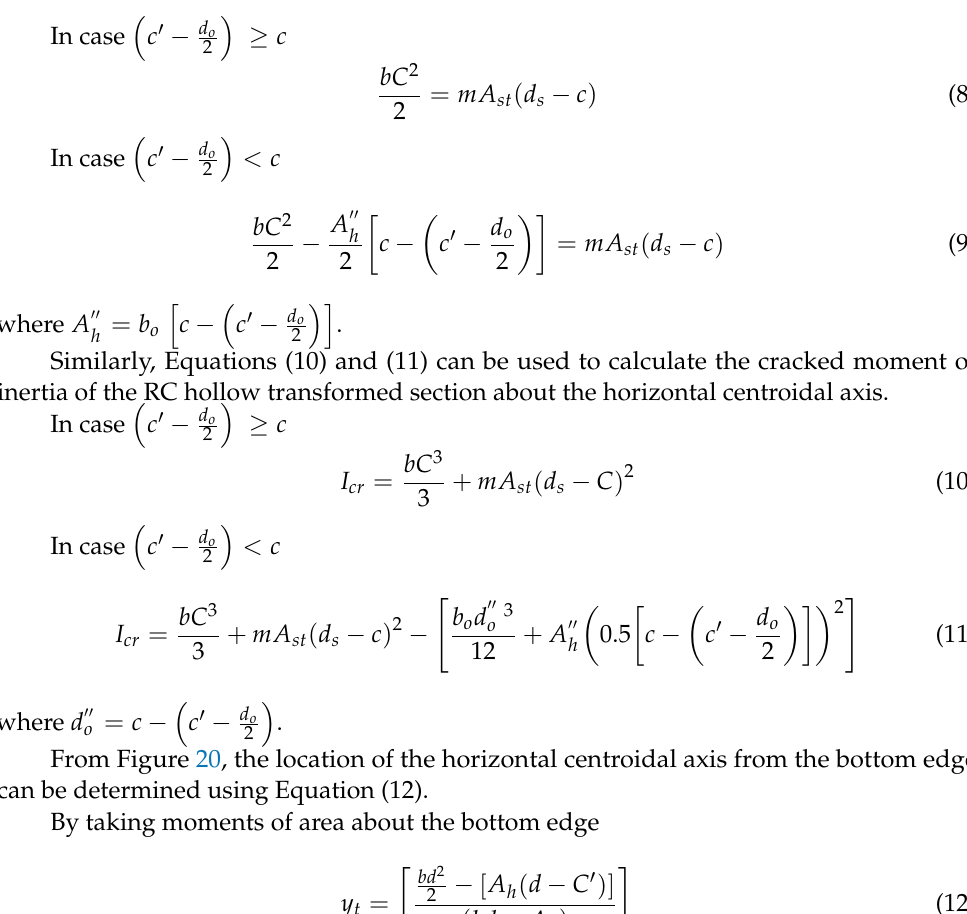
Figure 20. RC beam—transformed section after